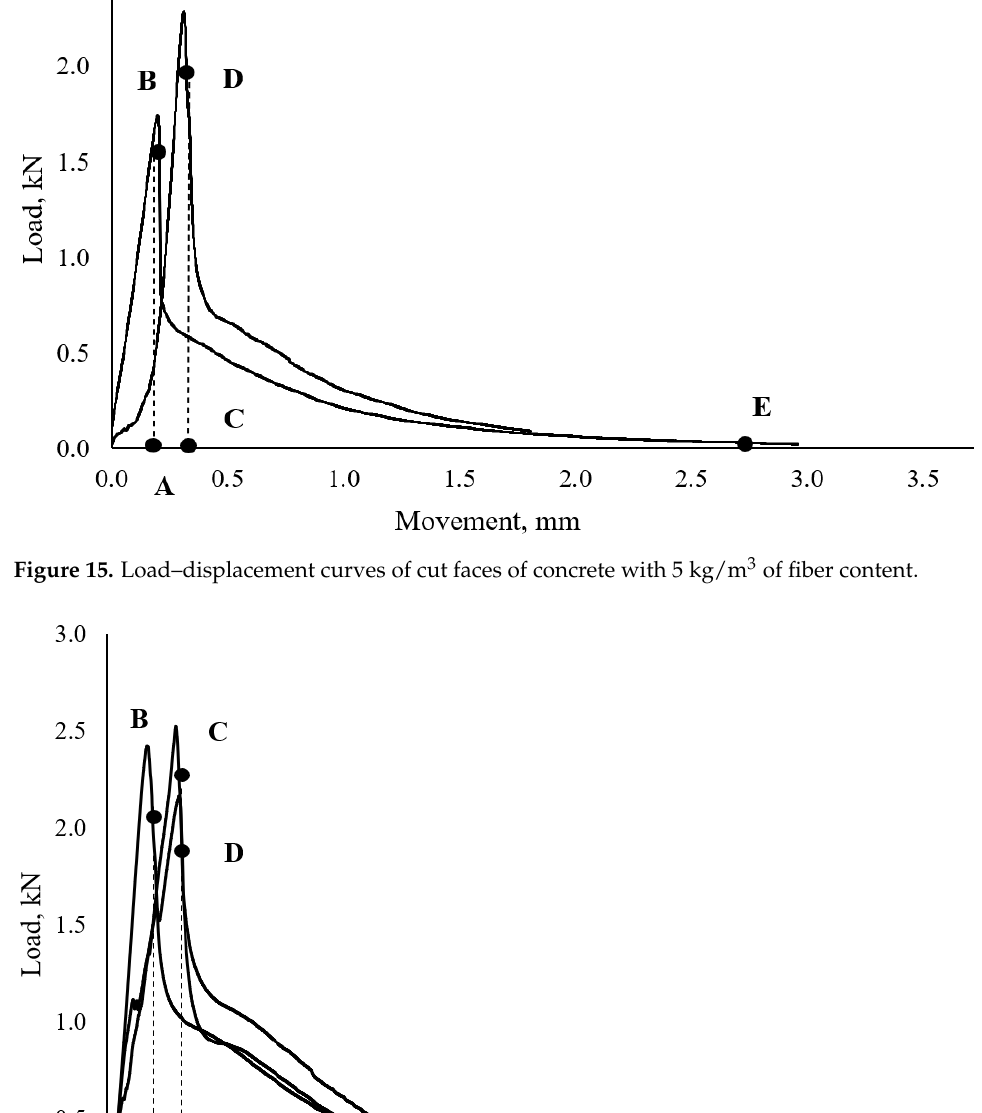
Figure 14. Load–displacement curves of cut faces of plain concrete specimens.